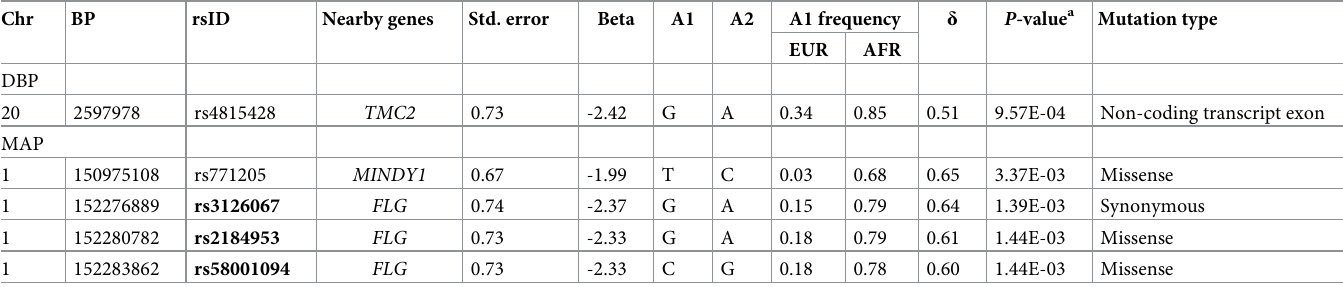
Table 3. Significant SNPs within admixture mapping peak